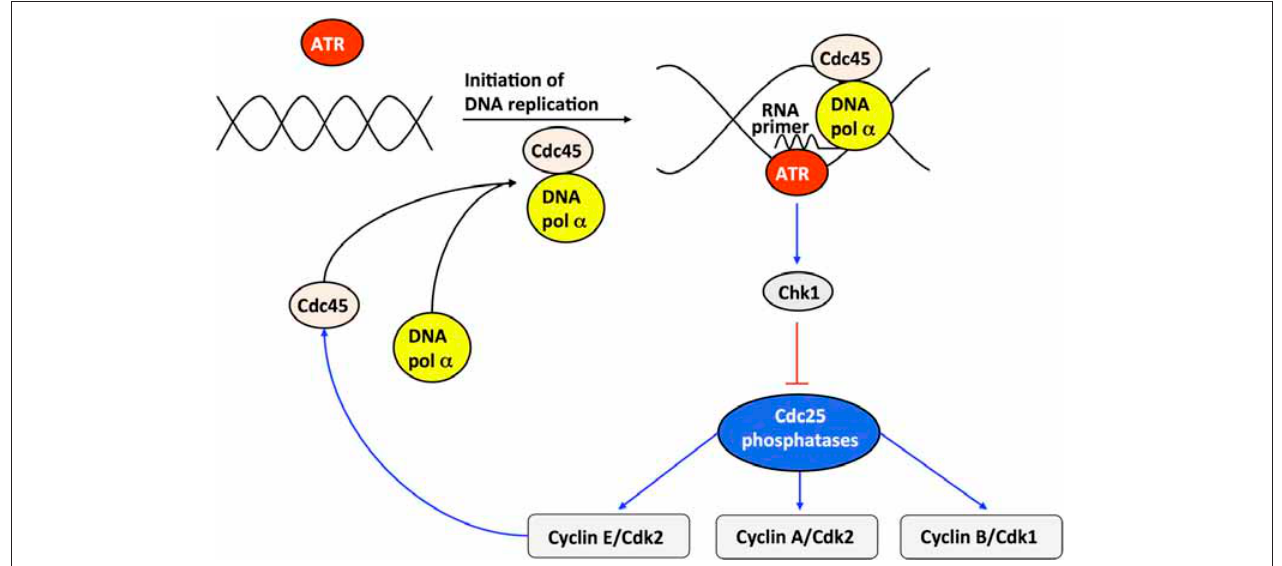
FIGURE 8 | Scheme of the DNA replication checkpoint regulated by kinases ATR and Chk1. At the G1/S transition, cyclin E/Cdk2 activates, by phosphorylation, the anchor factor Cdc45 that allows DNA polymerase α to bind to DNA. Upon initiation of DNA replication, DNA polymerase α synthesizes an RNA primer, which binds and activates the kinase ATR. The active form of ATR activates, by phosphorylation, the kinase Chk1. Once activated, Chk1 inhibits, by phosphorylation, the phosphatases Cdc25 responsible for the activation of cyclin E/Cdk2, cyclin A/Cdk2, and cyclin B/Cdk1. The inhibition of cyclin E/Cdk2 and cyclin A/Cdk2 during DNA replication creates a checkpoint, which limits the activation of Cdc45 and thereby prevents excessive initiation of DNA synthesis at multiple points of